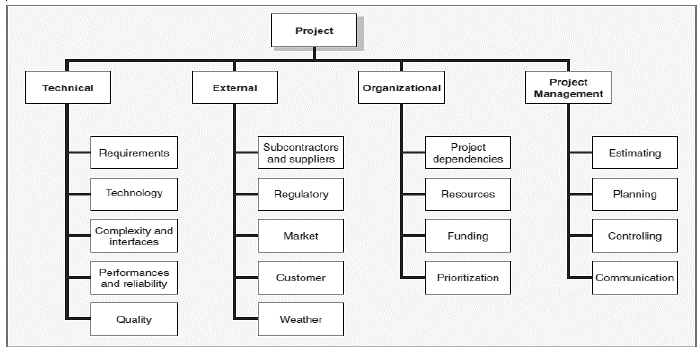
Figure 1. Project Risk Breakdown Structure